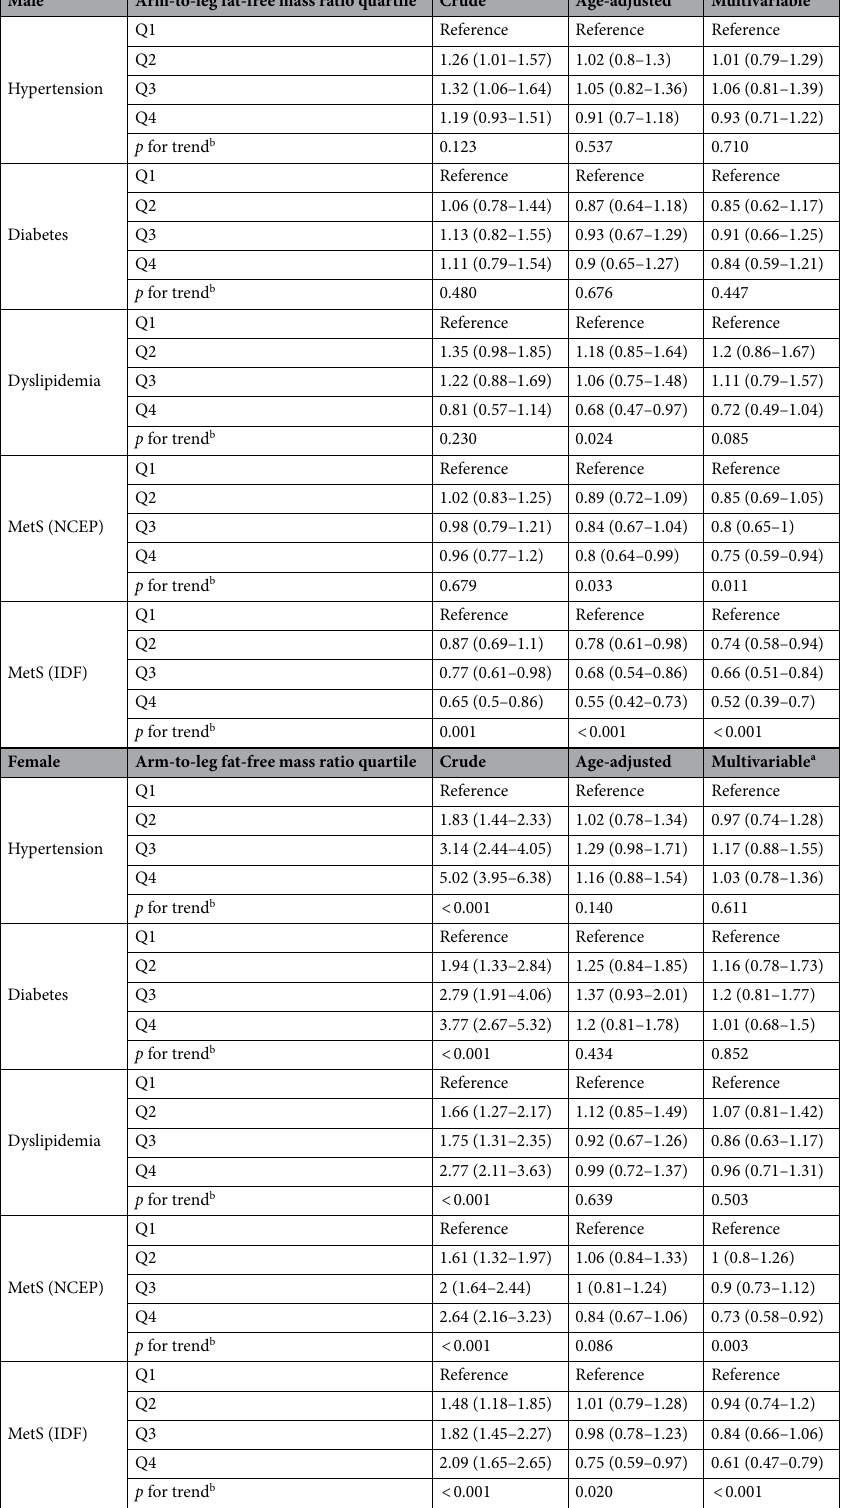
Table 5. Odds ratios for cardiovascular disease risk factors according to arm-to-leg fat-free mass ratio quartile. Data are presented as odds ratio (95% confidence interval). MetS, metabolic syndrome; NCEP, 2005 National Cholesterol Education Program Adult Treatment Panel III; IDF, 2006 International Diabetes Federation. a Multivariable model adjusted for age, energy intake, water intake per body weight, smoking, alcohol drinking, physical activity, education, income, and survey year. b Test for linear trend across quartile of arm-to-leg fat-free mass